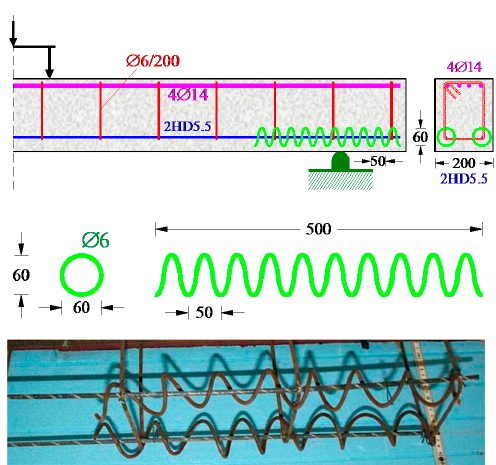
Figure 2. Application of local confinement along the anchorage length of the C-FRP bars for specimens BF5-1 (above figure), BF5-2, and BF10-1 (dimensions in mm). Table 1. Characteristics of the tested beams and experimental results